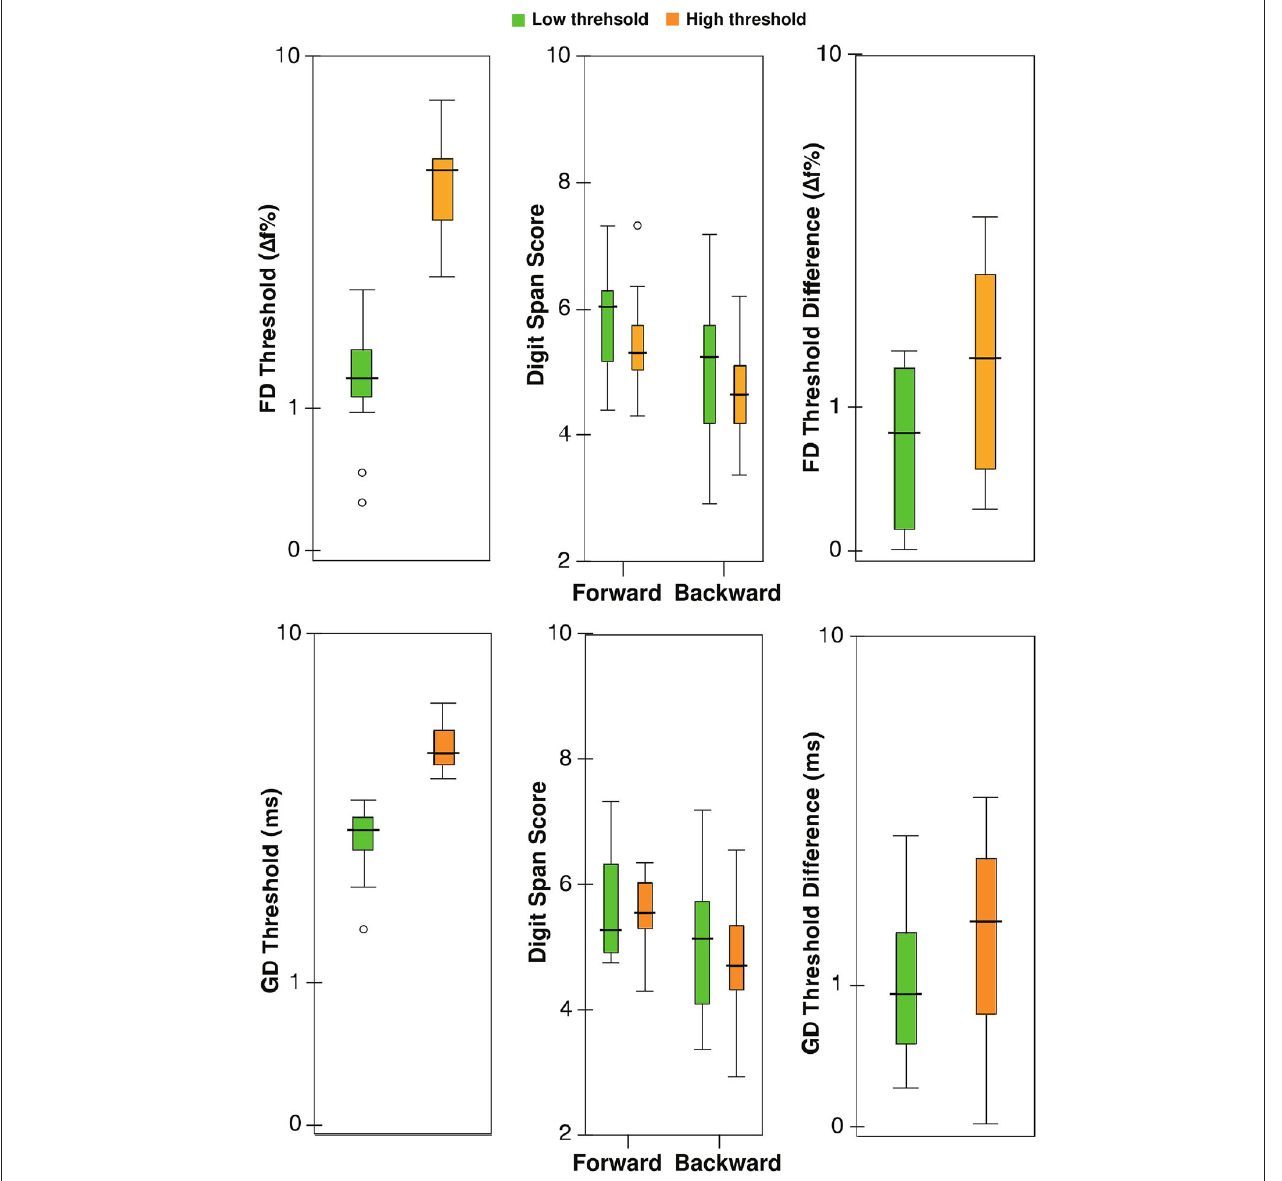
FIGURE 2 | Box-Whisker plots showing thresholds, digit span scores, and test-retest differences for lower and higher (poor) threshold groups for children based on median FD (upper panel) and GD thresholds (lower panel); ordinate is (safe 1 ) log-scaled for all but digit span. Horizontal lines indicate the median, boxes span from the 25th to 75th percentile, and whiskers show the maximum and minimum values. Separate data points are outliers.